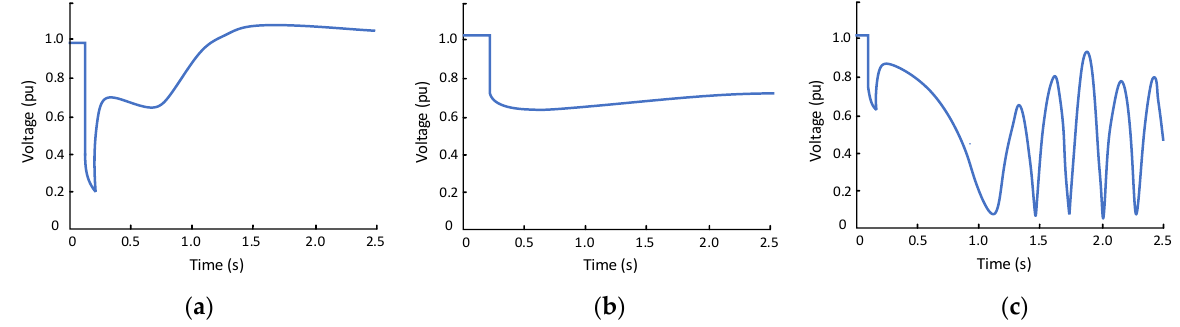
Figure 1. Short-term voltage stability phenomena: ( a ) FIDVR; ( b ) sustained low voltage; ( c ) rapid voltage collapse.